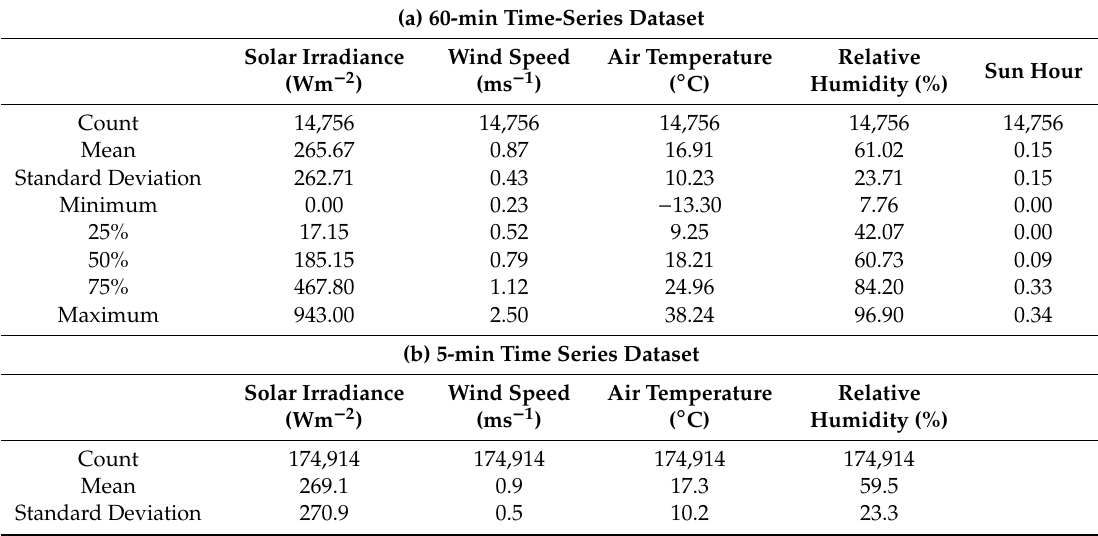
Table 2. Dataset’s statistical